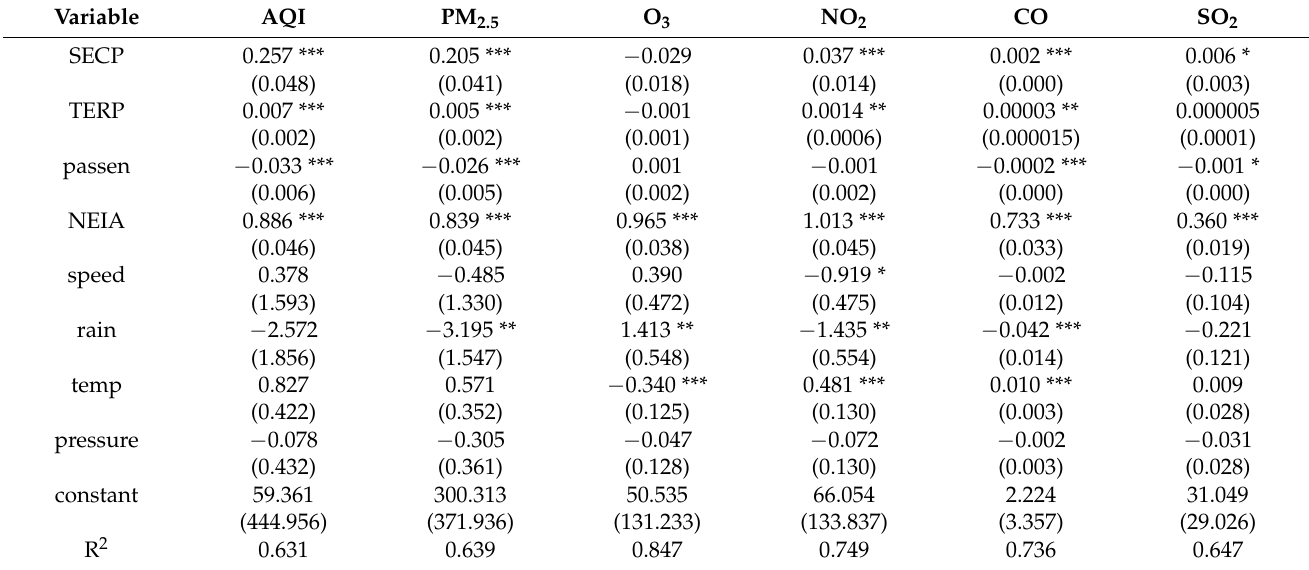
Table 4. OLS estimation results of industrial adjustment on air